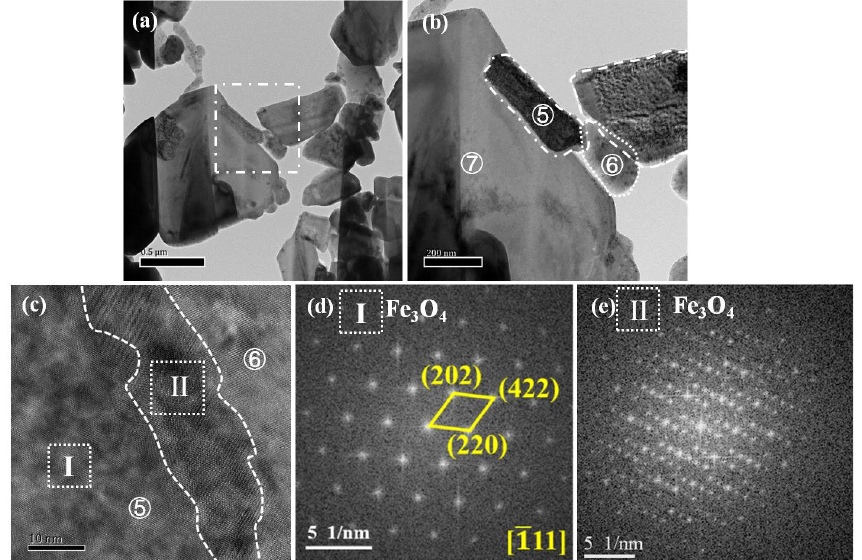
Figure 10. ( a ) TEM image of local magnification of the position of the left rectangle in Figure 8a. ( b ) TEM image of local magnification of the position of the red rectangle in ( a ). ( c ) HRTEM image of the interface between particle ⑤ and particle ⑥ in ( b ). ( d , e ) The FFT patterns of locations I and II marked by the rectangle in ( c ).